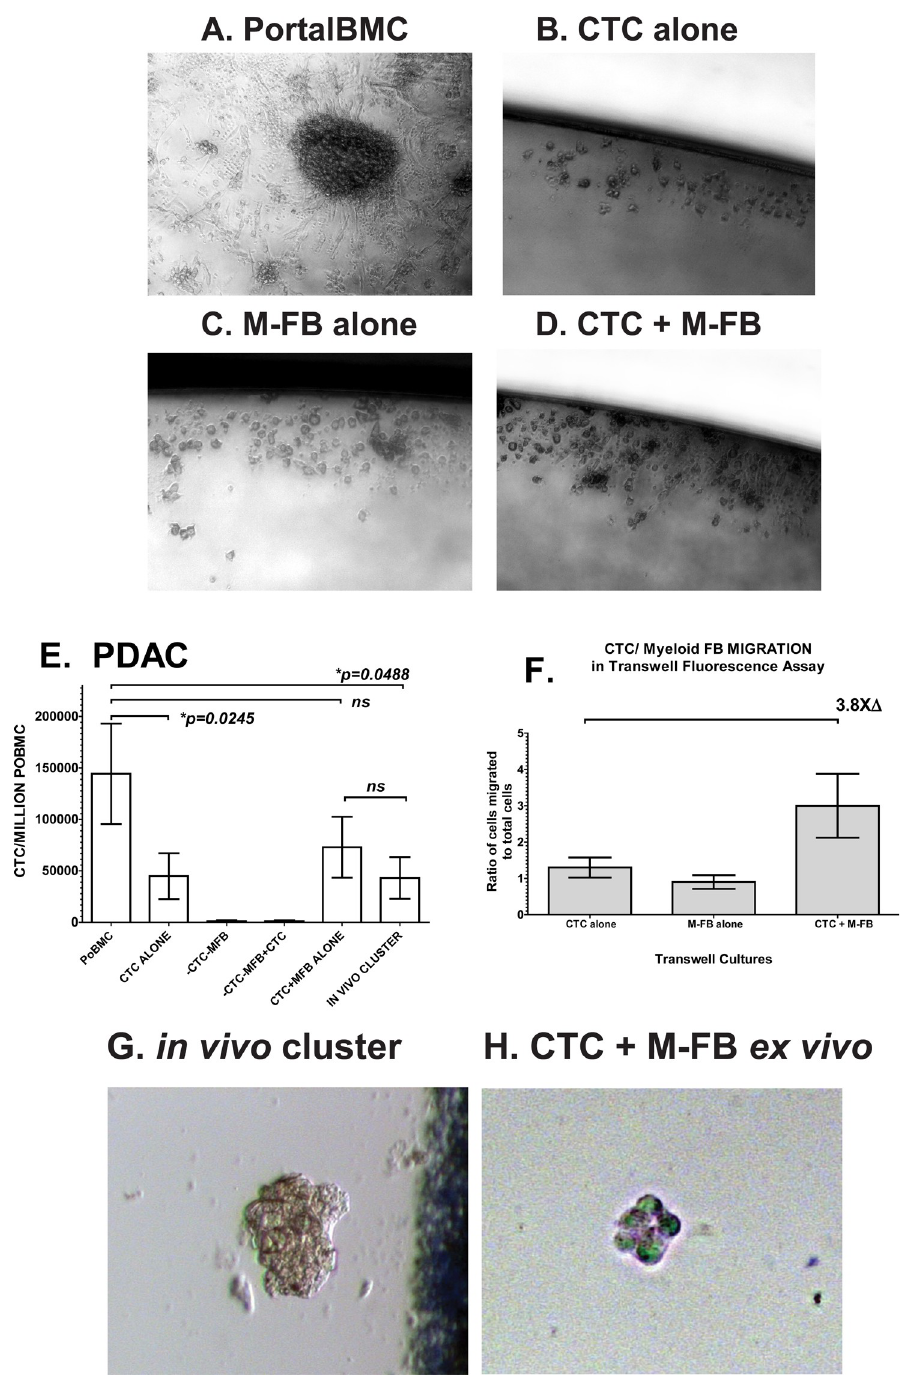
Fig 1. PDAC CTC/M-FB clusters promoted CTC proliferation and migration. PortalBMC were separated on histopaque gradients and CTC and M-FB cells isolated using aseptic FACS to yield selected populations for defined co- cultures to identify essential populations needed for CTC cluster formation in ex vivo cultures as previously described [11]. Clusters formed in 7-day cultures ( A,D ) by interactions between CTC and M-FB. Neither CTC ( B ) or M-FB ( C ) alone form clusters, though CTC alone can proliferate as a monolayer culture. CTC in 7 day ex vivo cultures of unsorted PortalBMC ( E , labeled as PoBMC ) from 16 PDAC patients showed CTC proliferation (mean ± SE) increased in in vivo and ex vivo formed clusters compared to FACS-isolated CTC cultured alone. Cultures containing FACS- isolated portal blood circulating tumor cells (labeled as CTC ) and FACS-isolated Myeloid-derived Fibroblasts (labeled as M-FB ) in defined co-cultures had comparable proliferation compared to PortalBMC cultured without separation